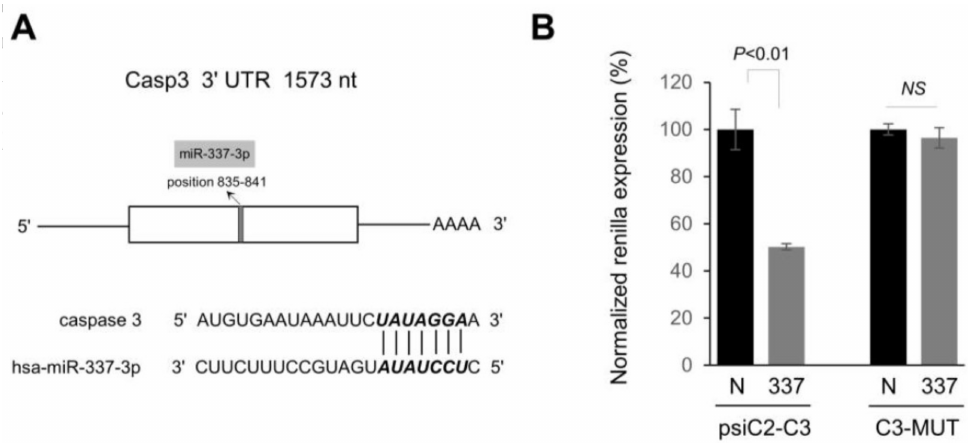
Figure 4. Caspase-3 (casp-3) is directly targeted by miR-337-3p. ( A ) Schematic diagram of human casp-3 mRNA and the predicted target site of miR-337-3p in the 3 (cid:48) UTR is shown. ( B ) Luciferase reporter plasmids carrying a wild-type (psiC2-C3) or mutant binding sequences in 3 (cid:48) UTR of casp-3 (C3-MUT) was transiently co-transfected in PANC-1 cells with pre-miR-negative control (N), or miR-337-3p precursor (337) at 50 nM concentration. At 24 h after transfection, luciferase activity was measured using dual-luciferase assays. Normalized Renilla luciferase activity in cells transfected with control oligo (N) was set at 100%. The data are the mean ± s.d. of at least 3 independent experiments. NS, Not significant.